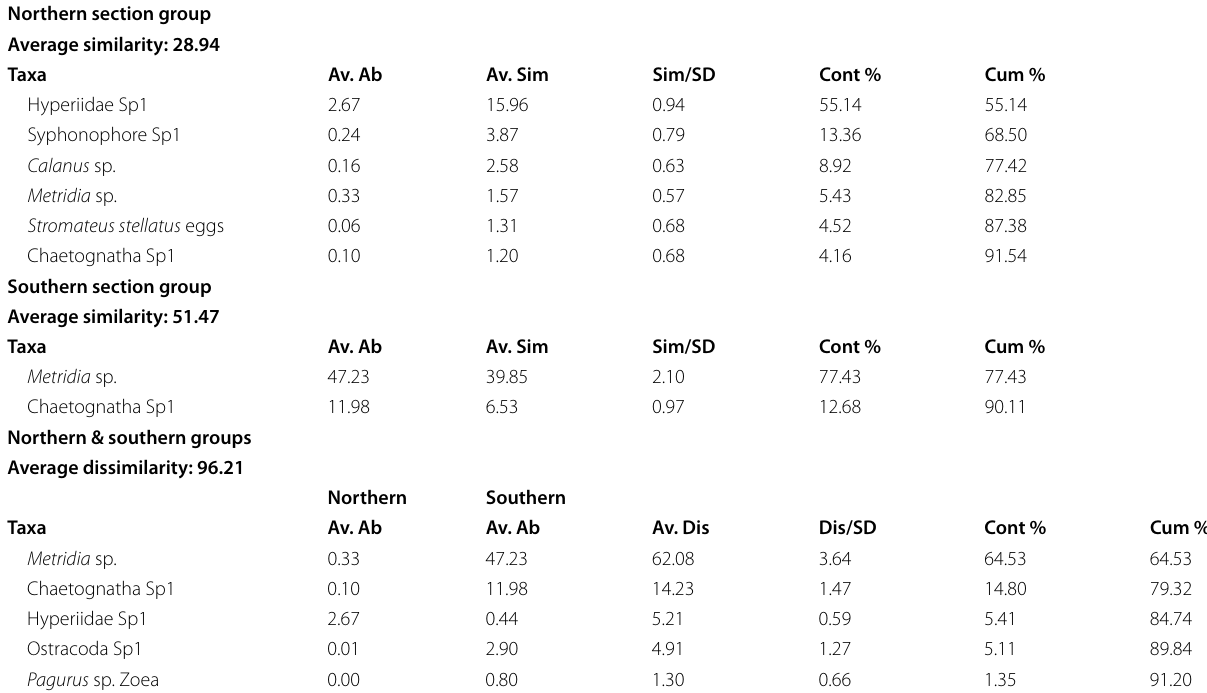
Table 4 Results of the SIMPER analysis for the zooplankton community in the surface stratum of the Caucahué Channel. Av: Average, Ab: Abundance, Sim: Similarity, Dis: Dissimilarity, Cont %: Taxa percentage contribution, Cum %: Cumulative percentage